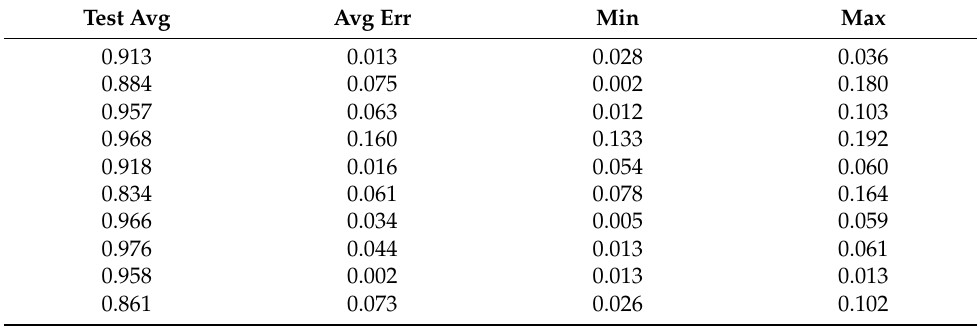
Table A99. Set 2, trials 11–20 data (single 0.5 PR value).